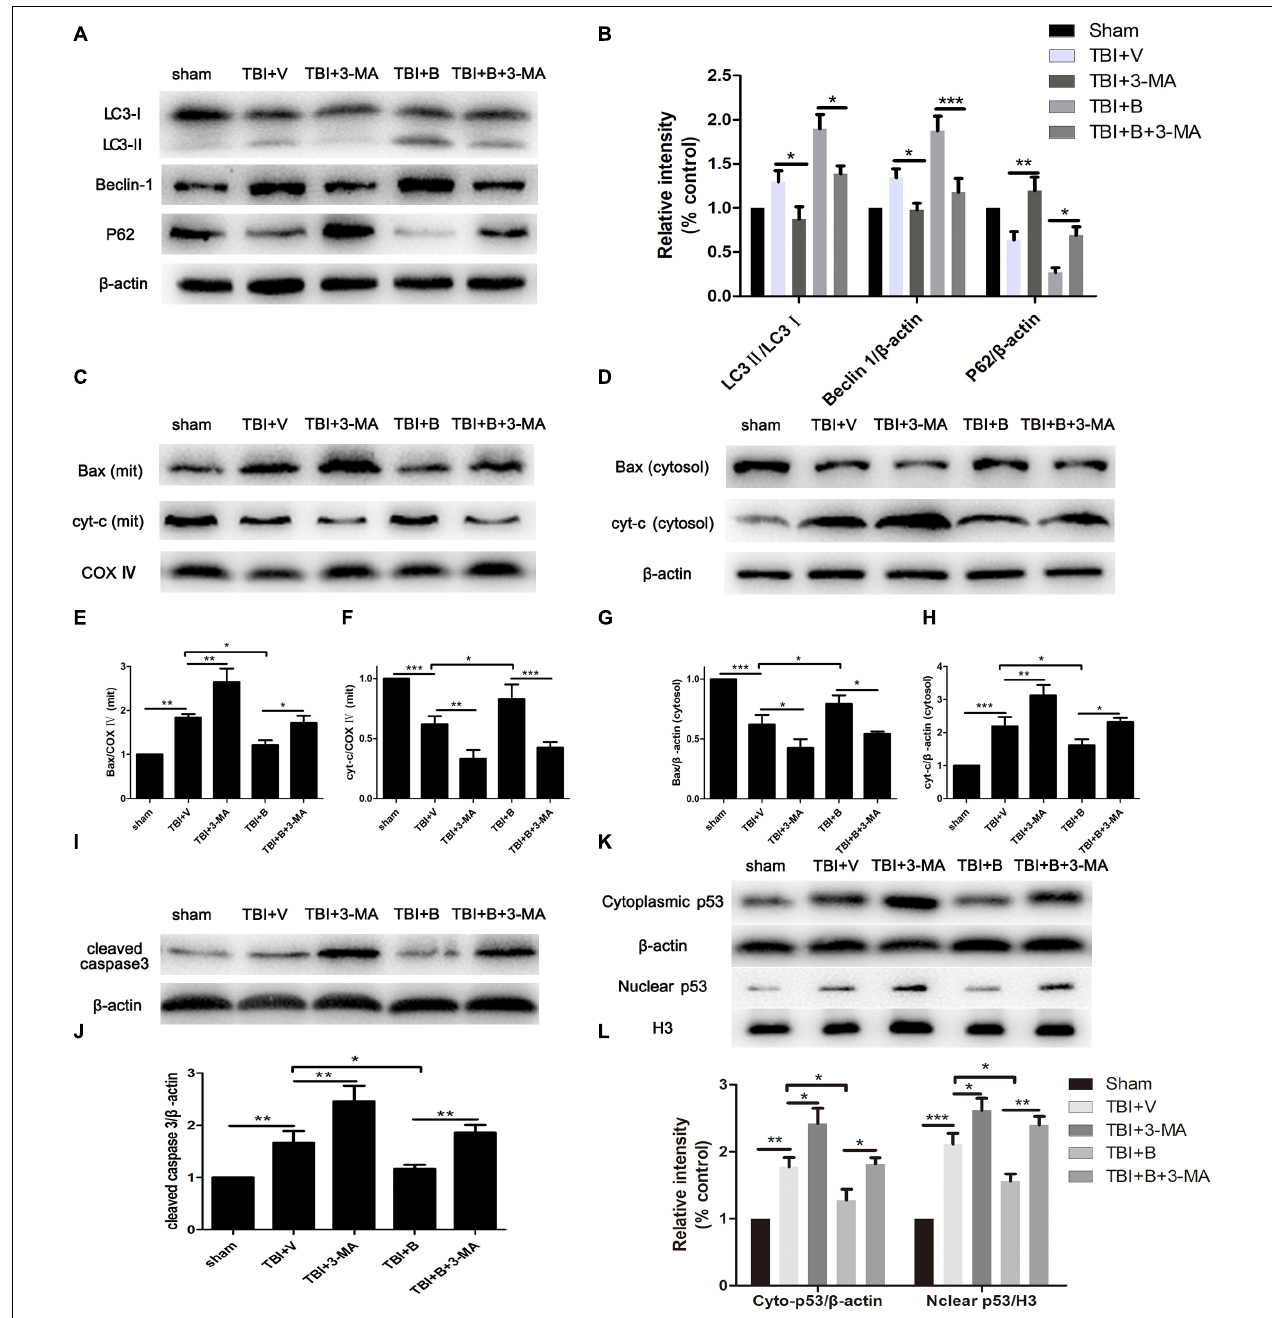
FIGURE 5 | 3-MA inhibited autophagy and reversed Baicalin-induced neuroprotection on mitochondrial apoptosis. Mice were divided into five groups: sham, TBI+ V, TBI+ 3-MA, TBI+ B, TBI+ B+ 3-MA. (A,B) The western blot band and semiquantitative analysis of LC3, Beclin 1, and p62. (C,E,F) The western blot band and semiquantitative analysis of Bax and cyt-c in mitochondrial fraction. (D,G,H) The western blot band and semiquantitative analysis of Bax and cyt-c in cytoplasmic fraction. (I,J) The western blot band and semiquantitative analysis of cleaved caspase 3. (K,L) The western blot band and semiquantitative analysis of cytoplasmic and nuclear p53. Data are represented as mean ± SD ( n = 6 per group). ∗ P < 0.05, ∗∗ P < 0.01, and ∗∗∗ P <